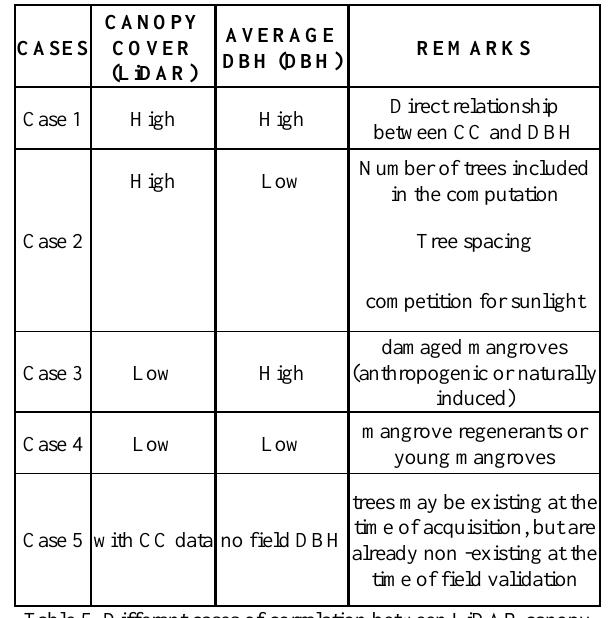
Table 5. Different cases of correlation between LiDAR canopy cover values and Field